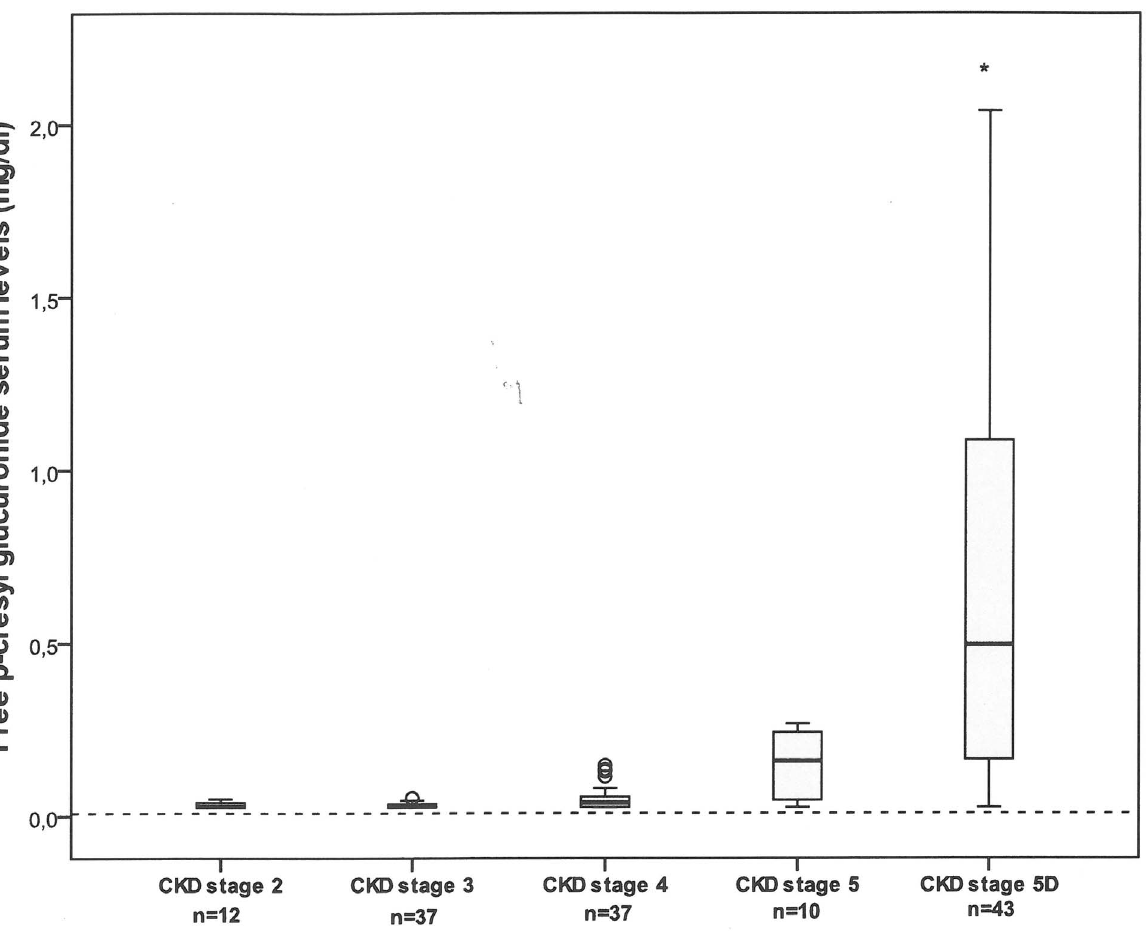
Figure 1. Serum levels of free p-cresylglucuronide as a function of CKD stage 2, 3, 4, 5 and 5D. *p , 0.0001. The dotted line indicates the reference value for healthy subjects (0.035 6 0.003 mg/dL).